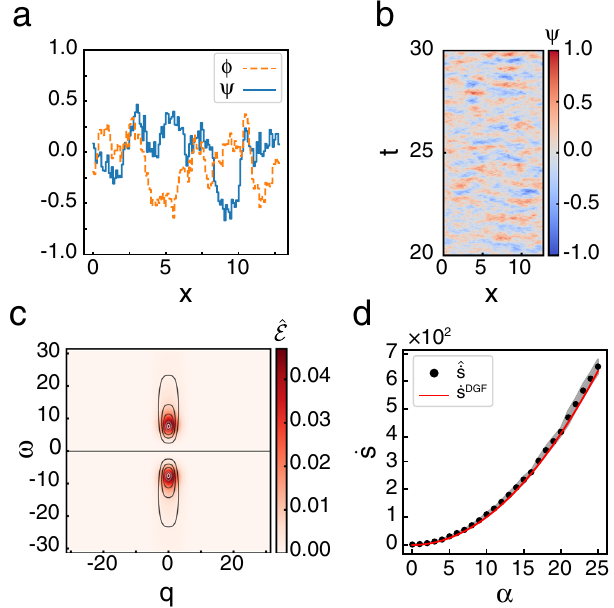
Fig. 1 Entropy production rate and entropy production factor are well estimated for driven Gaussian fi elds. a Snapshot of typical con fi gurations of both fi elds, ψ (blue solid line) and ϕ (orange dashed line) obeying Eq. (5) for α = 7.5. b Subsection of a typical trajectory for one fi eld for α = 7.5 in dimensionless units. Colors indicate the value of the fi eld at each point in spacetime. c ^ E for α = 7.5 averaged over N = 10 simulations. Contours show level sets of E DGF . d Measured _ s vs. α for simulations of total time T = 50 and length L = 12.8. Red line shows the theoretical value, _ s DGF . Mean ± s.d. of ^_ s given by black dots and shaded area. See Supplementary Table 1 for all simulation